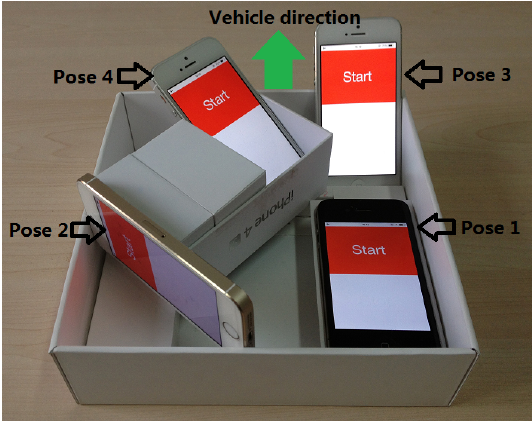
Figure 7. A platform is with four iPhones.